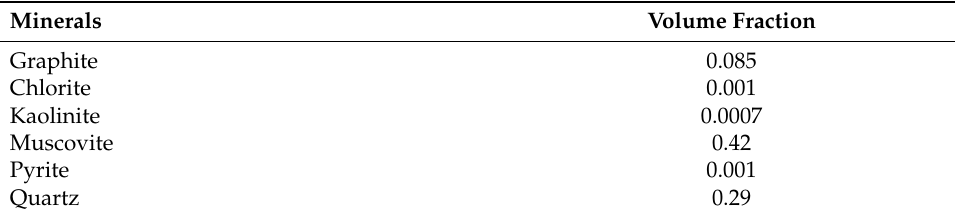
Table 5. Initial mineral volume fractions of the faulted graphite